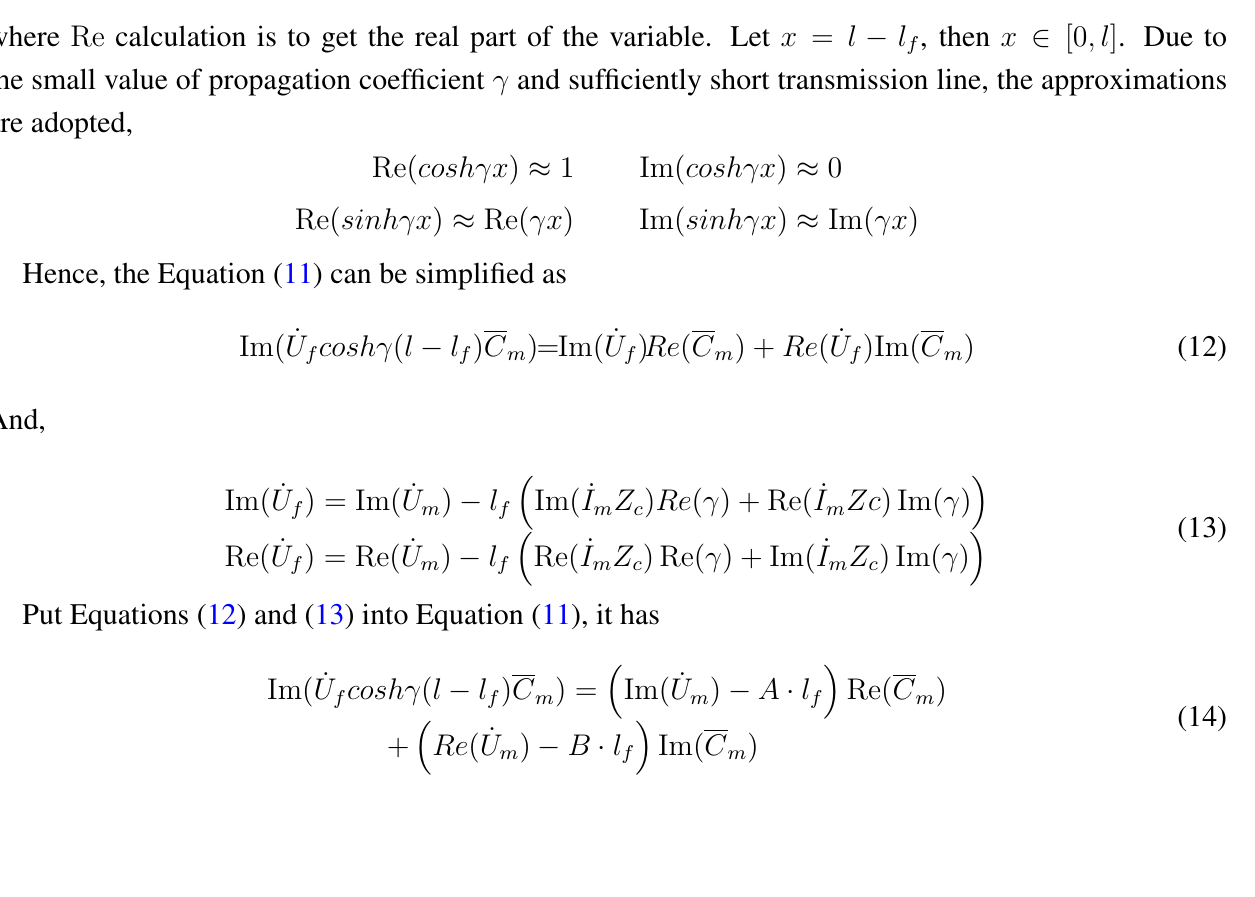
Figure 4. The relationship between the fault distance l